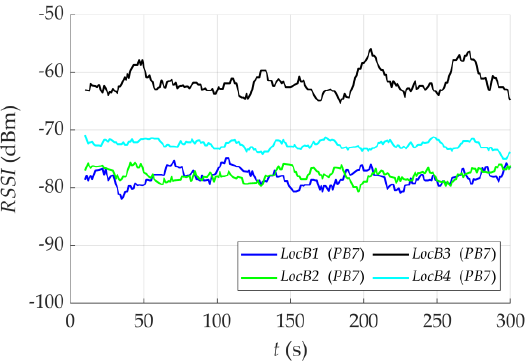
Figure 18. RSSI sequences averaged in a moving window with a width of M = 10 for four locator nodes and an object placed in front of the LocB3 receiver at a distance of 0.5 m (location PB7 ).